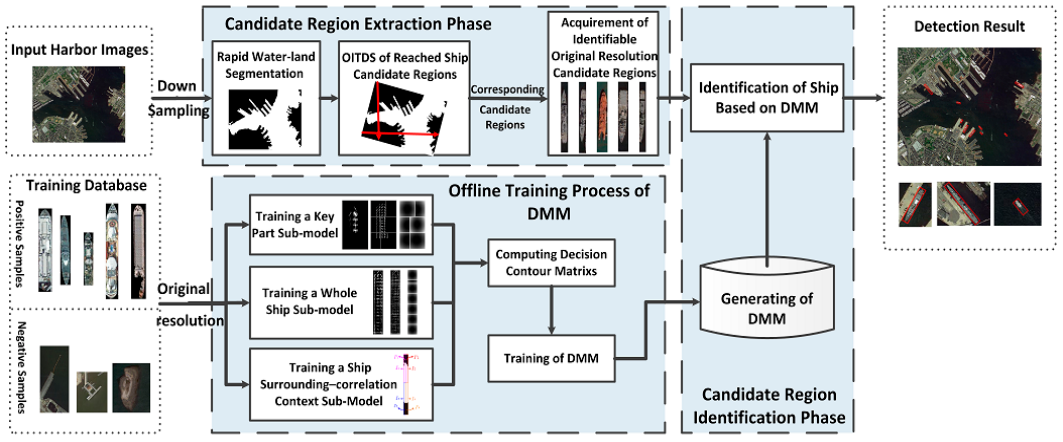
Figure 1. Workflow of the proposed detection algorithm. DMM: decision mixture model.